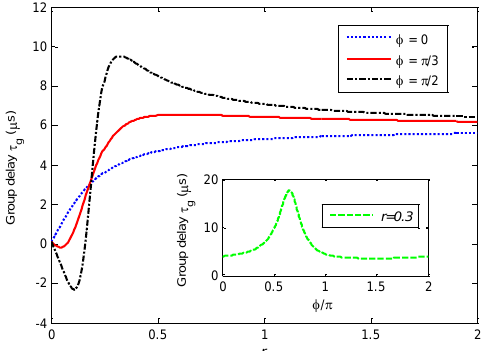
Figure 6. Curves of group delay τ g at ∆ / ω m = 0.99 vary with r = µε q / ε p for different phase difference. The inset of Figure 6 shows the curve of τ g varies with φ at r = 0.3. The other parameters are the same as those in Figure 2 except for ε c /2 π = 0.9